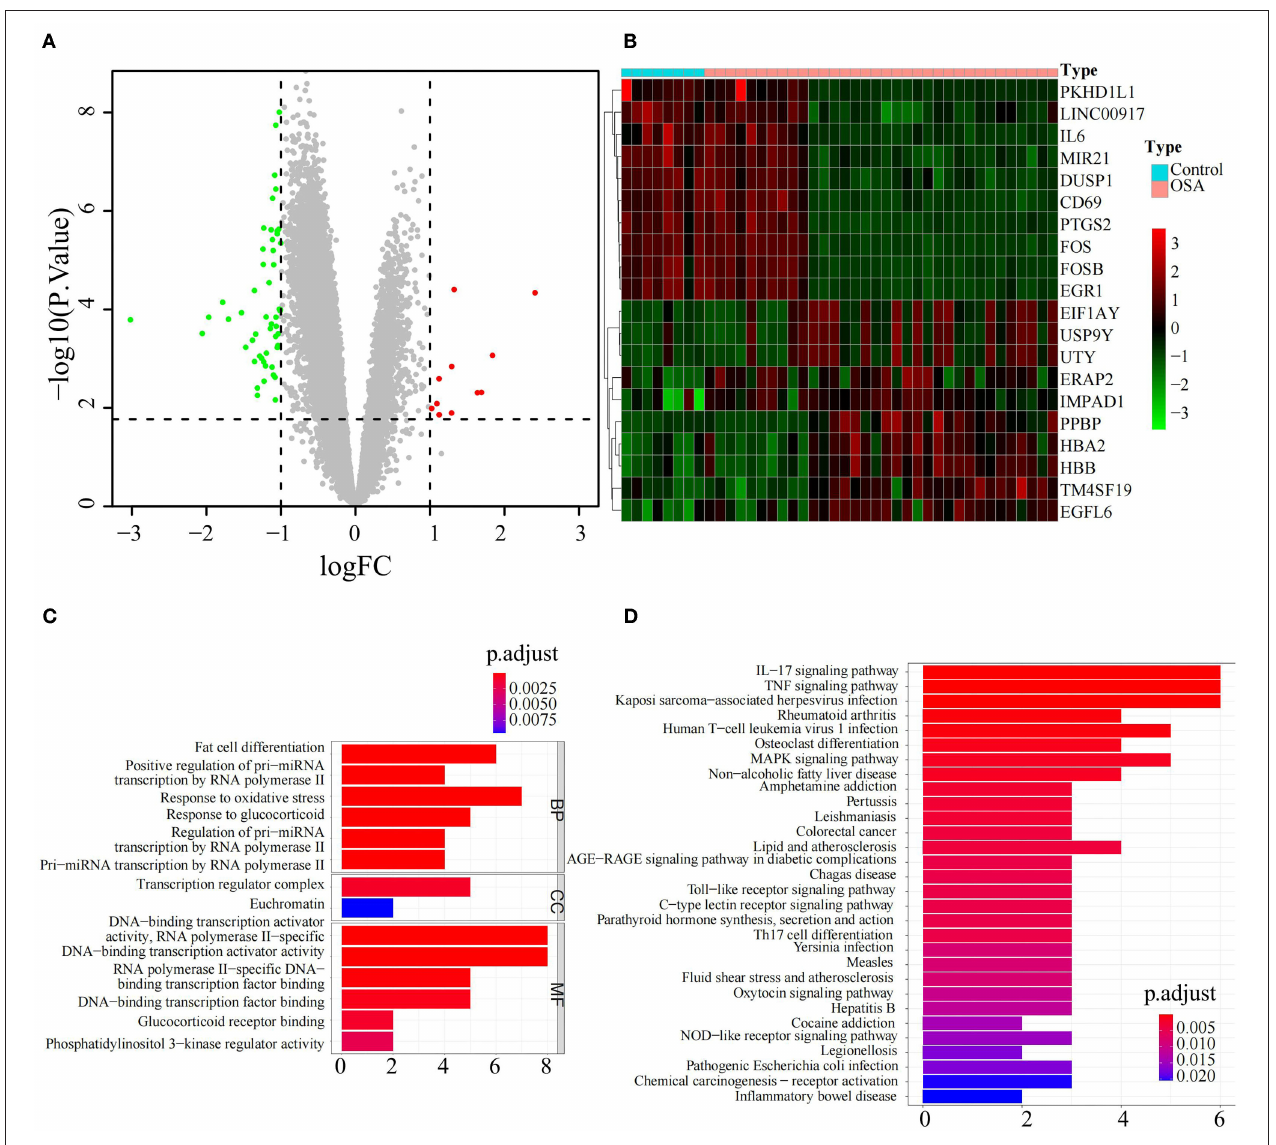
FIGURE 1 | Identification and functional analysis of differentially expressed genes between OSA and control subjects. (A) Volcano plot of the DEGs, including 11 upregulated genes in red and 52 downregulated genes in green, between OSA and control subjects. (B) Heatmap showing the expression of the top 10 upregulated genes and top 10 downregulated genes in OSA compared with control subjects. (C) Bar chart showing the GO enrichment analysis of DEGs, including biological processes, molecular functions, and cellular components. (D) Bar chart showing KEGG enrichment analysis of